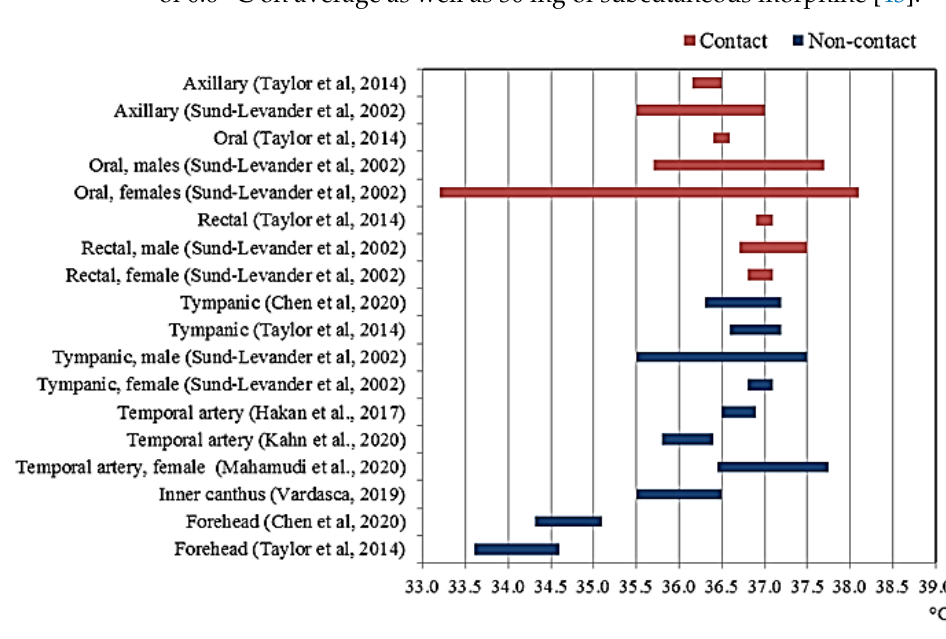
Figure 3. Measured body temperature variability at different body sites .